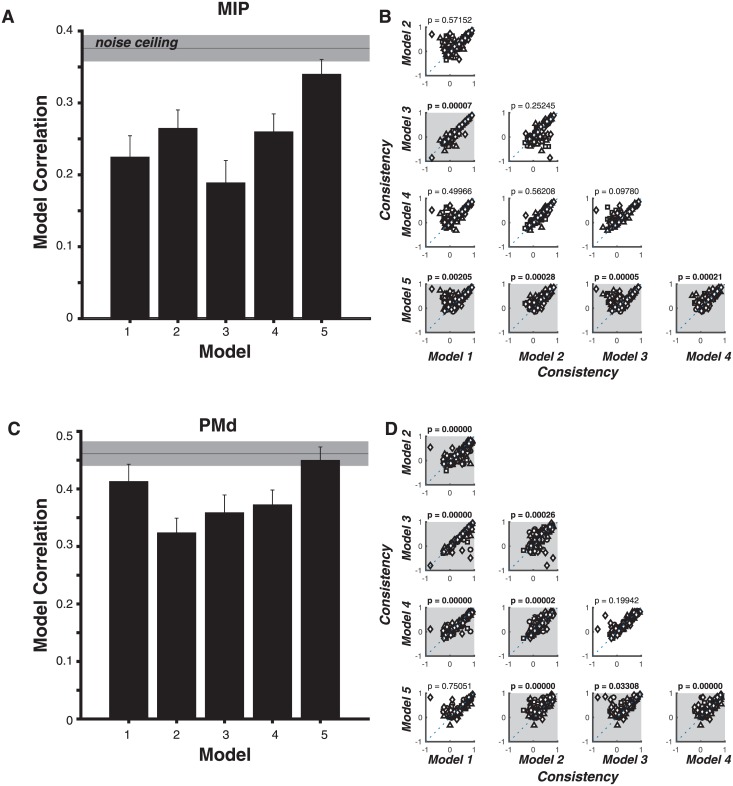
(A) Model Consistency. For each of the five tested models, the resulting distribution of model consistencies over all task-related MIP neurons and all epochs (mean ± SE) is shown for each model. The gray horizontal bar corresponds to the noise ceiling (internal consistency of the neuronal response patterns, mean ± SE). (B) Quantitative comparison for each pairwise combination of models. Each panel (row i, column j) directly compares two models (model #i vs. model #j), and each point in the panel’s scatter plot corresponds to a particular neuronal response pattern in MIP. The dashed unity line corresponds to equal consistency across these two models. The p-value obtained from a two-tailed signed rank test comparing the distributions of correlations between models i and j is shown in the panel title, and model pairs with statistically significant differences are highlighted in grey. (C, D) Identical to (A,B) for task-related neurons in PMd.